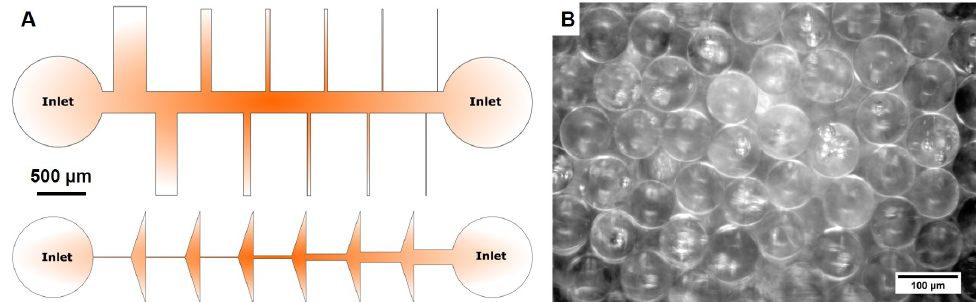
Figure 1. The fabricated micromodels used to study the epoxy impregnation parameters. ( A ) Two patterns engraved in silicon micromodels. ( B ) The sintered glass beads inside a 1-mm square glass capillary imaged with an optical